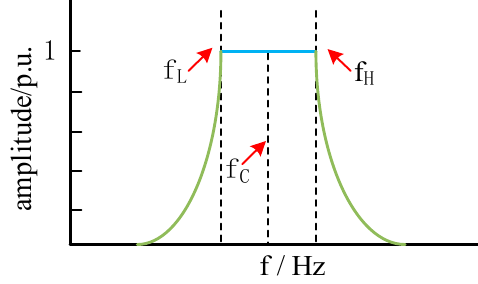
Figure 2. ABPF parameter design schematic.